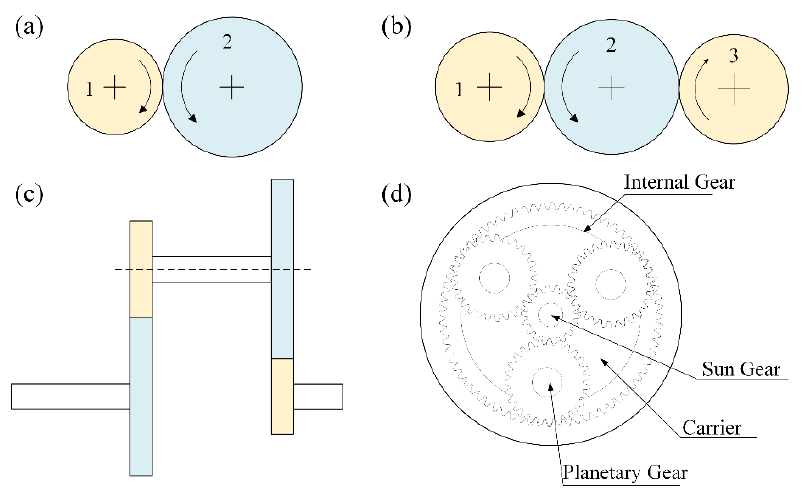
Figure 1. Four types of gear trains: ( a ) simple gear train, ( b ) compound gear train, ( c ) reverted gear train and ( d ) planetary gear train.